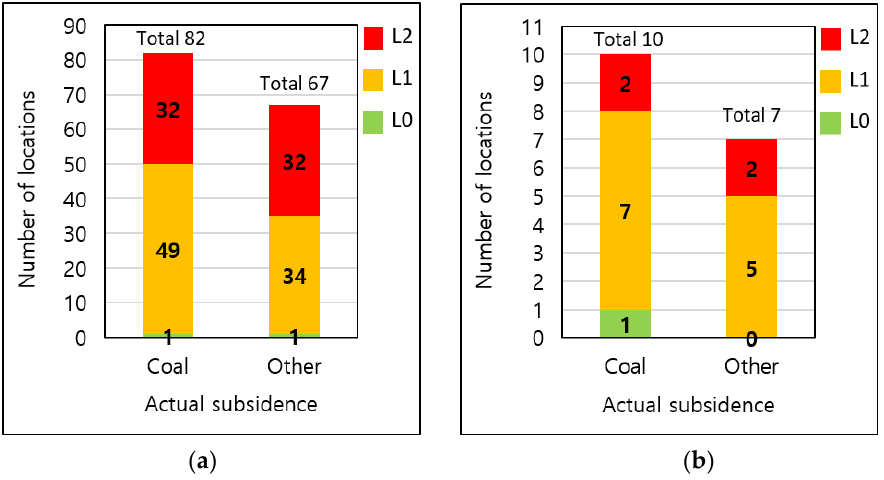
Figure 17. Subsidence risk grade for coal mines and other types of mines: ( a ) training data and ( b ) validation data.